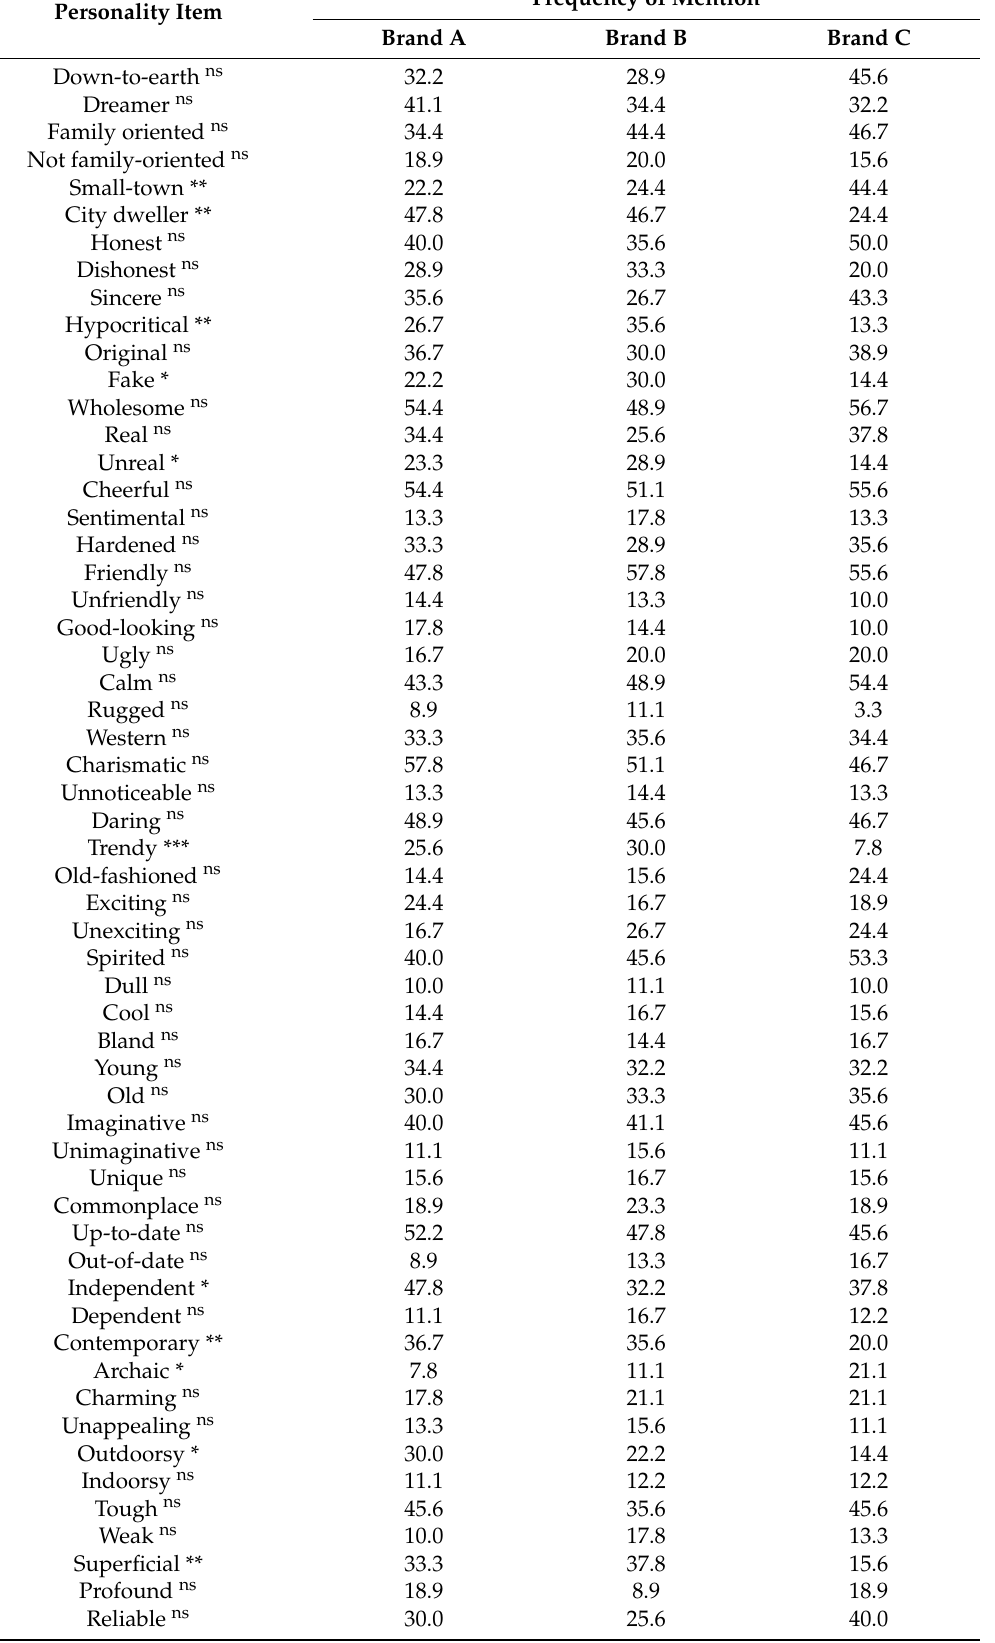
Table 4. Frequency of mention for each personality trait according to cream liqueur brand in Costa Rica. The association to personality item was done indirectly via the intermediate selection of a